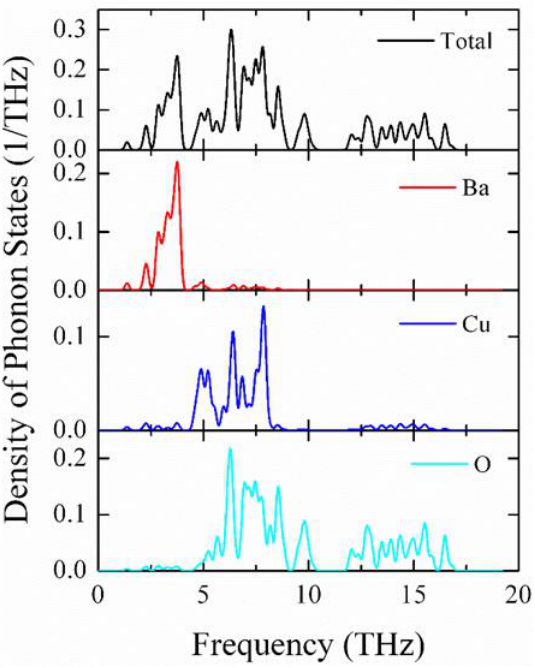
Figure 12. Density of phonon states of BaCuO 3 at zero pressure.